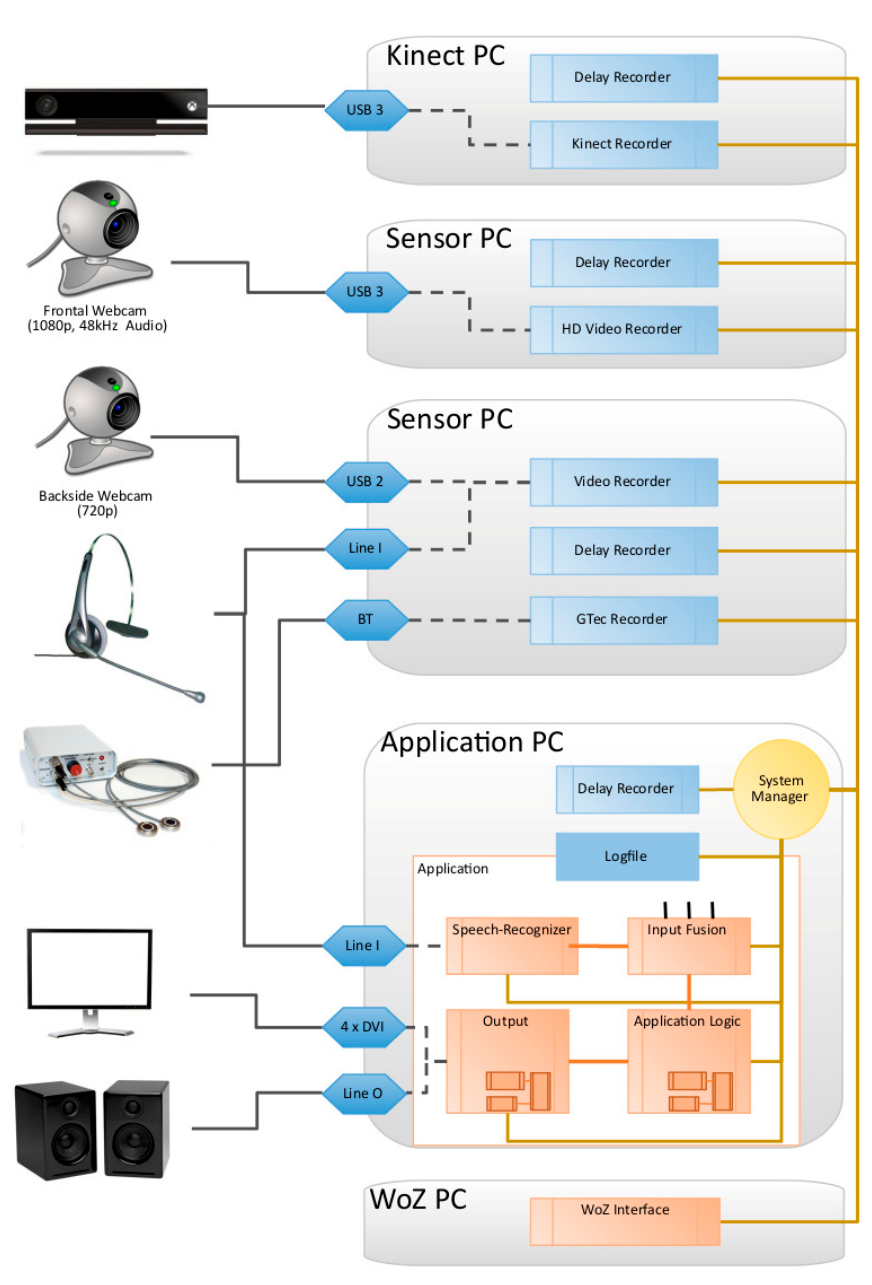
Figure 5. Technical infrastructure of the distributed experimental and recording setup.